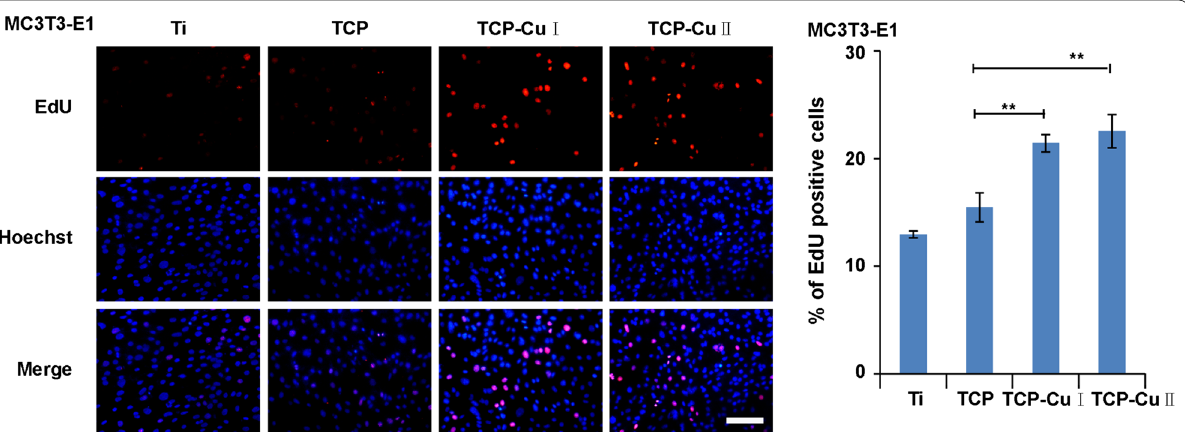
Fig. 7 EdU staining measured after 3 days of culturing (Data are presented as mean